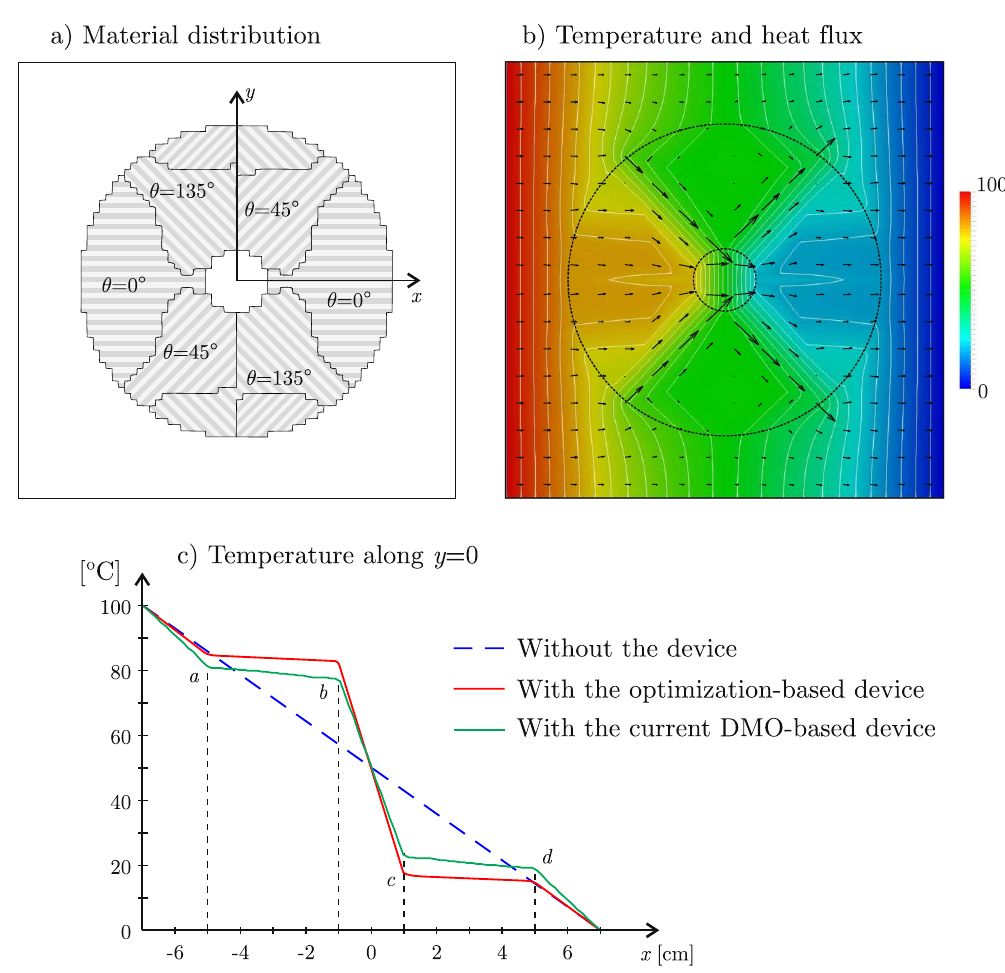
Figure 5. Heat flux concentration and cloaking example: ( a ) DMO-designed device, ( b ) temperature (colormap with isolines every 4 °C) and heat flux (arrows) in the whole plate, ( c ) temperature along y = 0 for the current DMO-designed device and the optimization-designed one with continuous metamaterial distribution 9